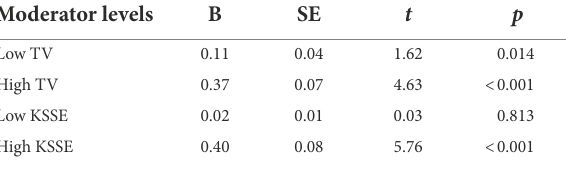
TABLE 4 Summary of the simple slope tests.